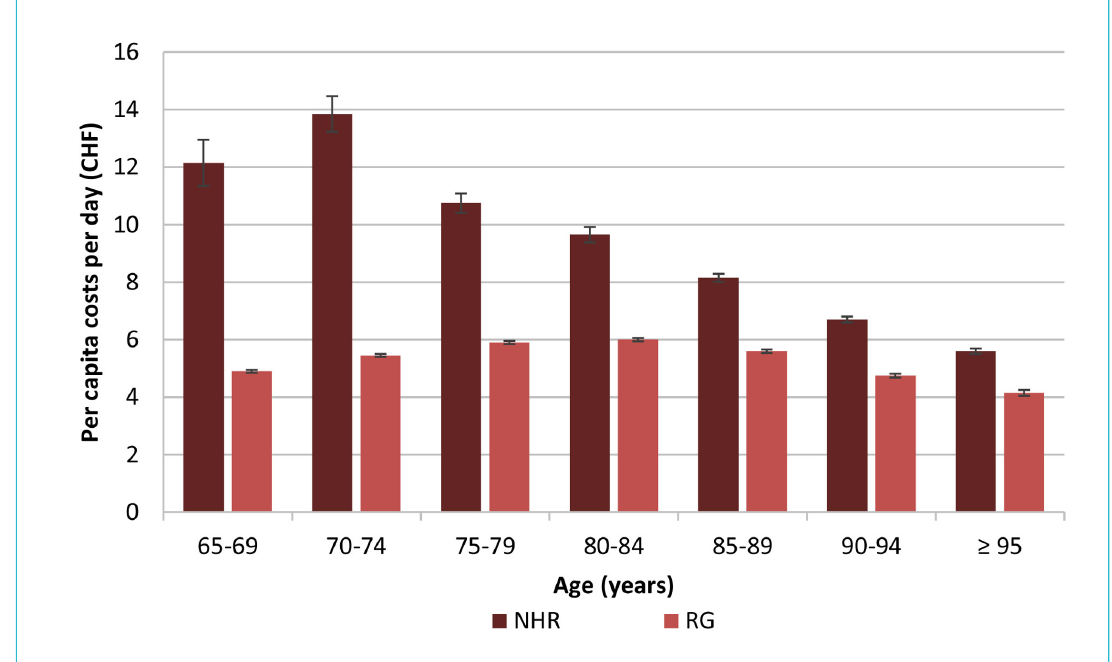
Figure 1: Average per capita drug costs per day in different age groups for NHR and the RG (individuals aged ≥65 years insured with Hel- sana, excluding NHR) with 95% confidence intervals, year 2016.NHR = nursing home residents; RG = reference